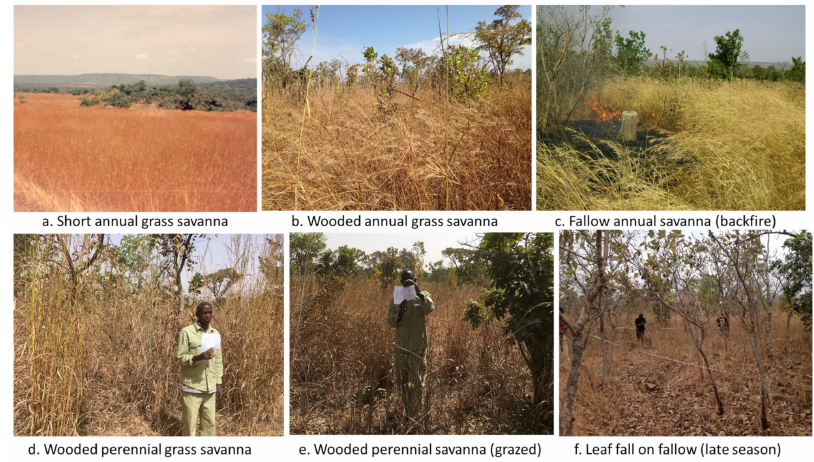
Figure 6. Examples of different vegetation types and conditions in Mali (Photographs by P.